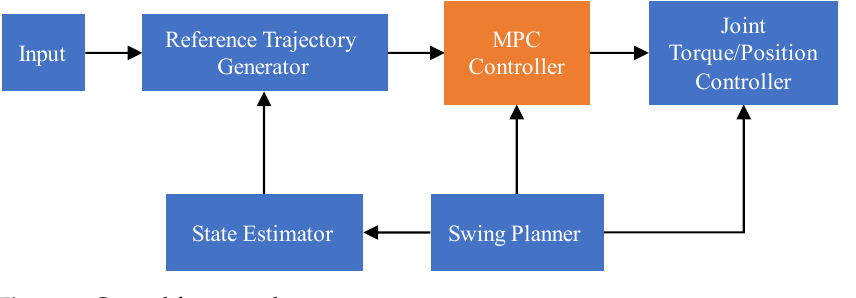
Figure 2. Control framework .